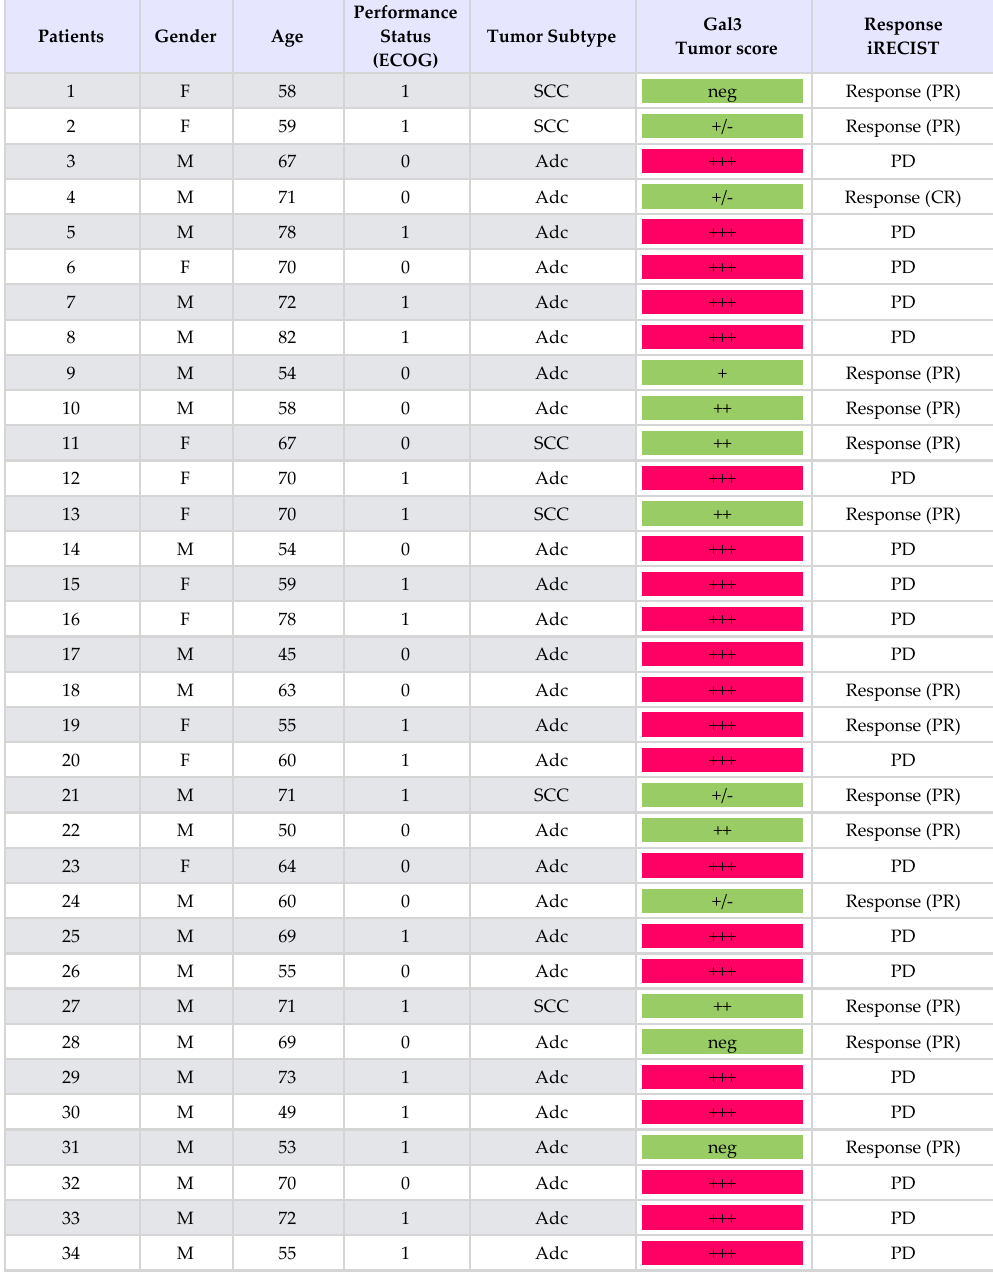
Table 1. Clinical features of the patients and non-small cell lung carcinoma (NSCLC)